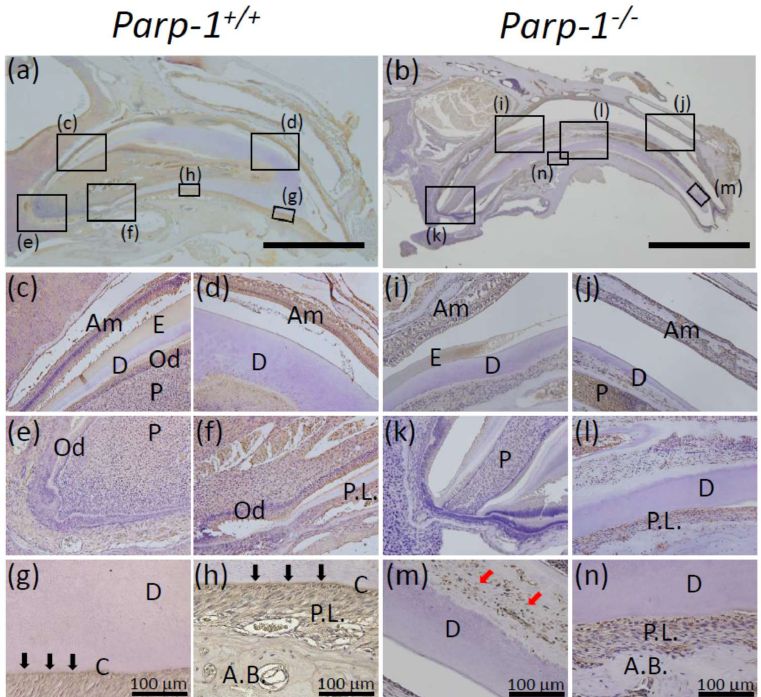
Figure 9. Immunohistochemical analysis of bone sialoprotein (BSP) expression of aged Parp-1 +/+ and Parp-1 −/− incisors (C57BL/6). Expression of BSP in the sagittal plane of Parp-1 +/+ ( a ) and Parp-1 −/− incisors ( b ). BSP was detected at periodontal ligament in both Parp-1 +/+ ( a,f,g,h ) and Parp-1 −/− incisors ( b , l , n ). BSP was also detected in dentin area of Parp-1 − / − incisor ( i – n ; red arrows) but not in Parp-1 +/+ incisor ( a , c , d , e , g ). Moreover, BSP positive cementum was observed as linear structure in Parp-1 +/+ incisor between dentin and periodontal ligament ( g , h ; black arrows), whereas it was hardly observed in Parp-1 −/− incisor ( n ). Semi-quantitative analysis showed that the average values of relative intensities of BSP positivity in dentin area were 42.4 ± 2.7 and 107.8 ± 7.4 in Parp-1 +/+ and Parp-1 −/− incisors, respectively ( g , m ). Am, ameloblast; Od, odontoblast; E, enamel; D, dentin; P.L., periodontal ligament; P, pulp; A.B., alveolar bone. Arrows indicate the predentin area showing scattered BSP-positive area. Bars of ( a , b ) indicate 2 mm. The representative results of a mouse for each genotype are shown.